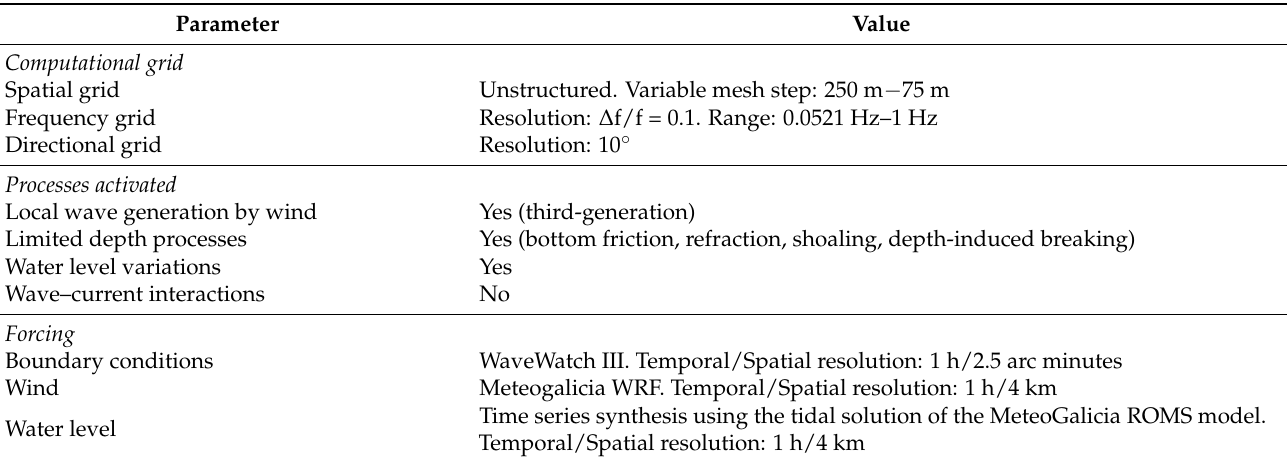
Table 1. Main characteristics of the SWAN model set up in the present